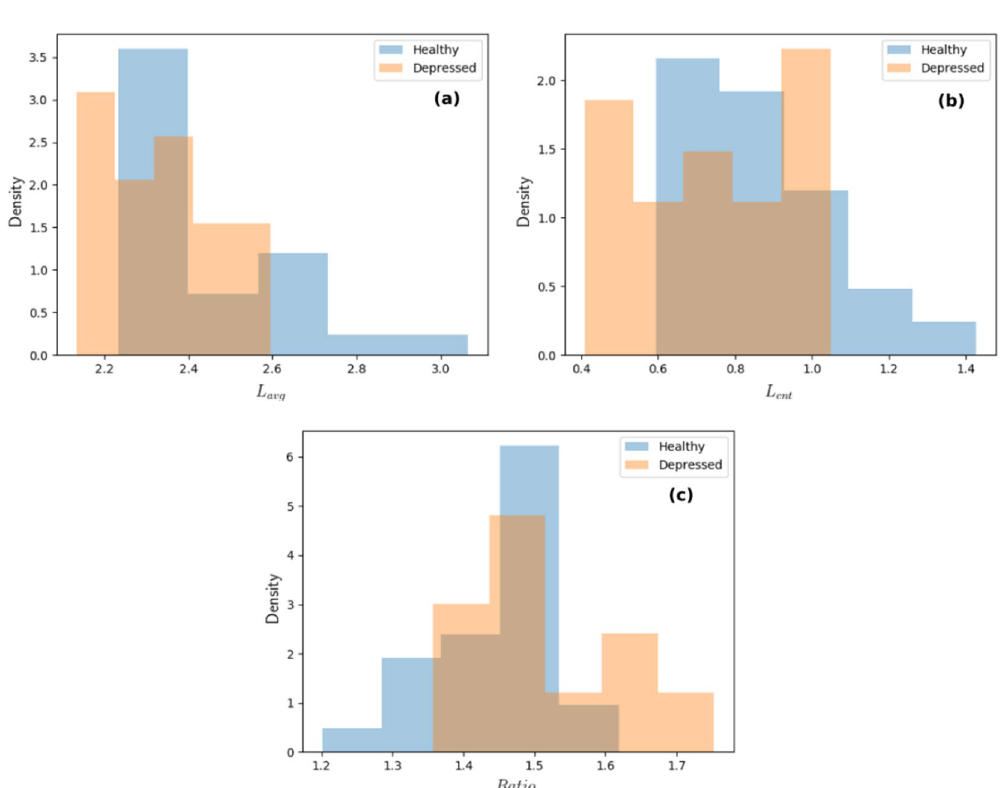
Figure 6. Histograms showing the difference in ( a ) mean diagonal length, ( b ) entropy and ( c ) ratio of determinism to laminarity between the non-depressed and depressed